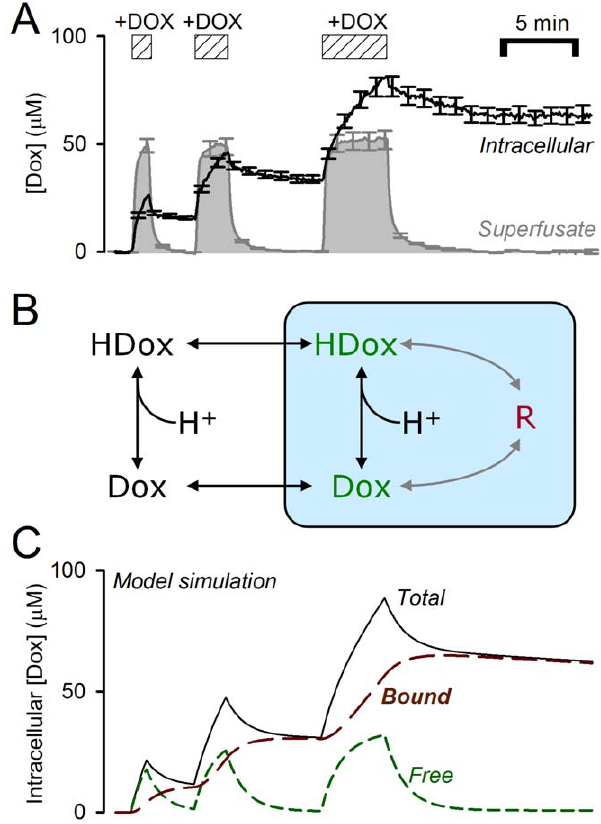
Figure 1. Intracellular doxorubicin associates with a slowly- releasing intracellular binding site. (A) HCT116 cells superfused with Hepes/Mes buffer at pH=7.4, 37 u C. Doxorubicin (DOX; 50 m M) was applied transiently by switching rapidly between drug-free and drug- containing solution (average of 25 cells, 6 SEM). (B) Proposed model with equilibria involving free and bound doxorubicin. (C) Mathematical simulation showing the fast rise of intracellular doxorubicin upon exposure, and its slow release upon reversal of the trans-membrane concentration gradient.